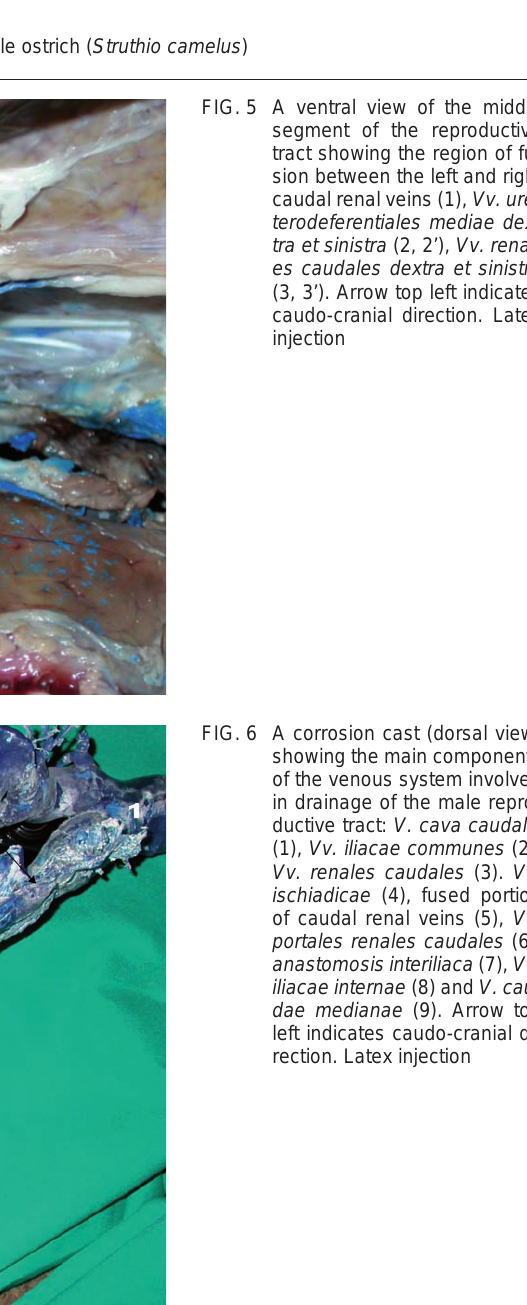
FIG. 6 A corrosion cast (dorsal view) showing the main components of the venous system involved in drainage of the male repro- ductive tract: V. cava caudalis (1), Vv. iliacae communes (2), Vv. renales caudales (3). Vv. ischiadicae (4), fused portion of caudal renal veins (5), Vv. portales renales caudales (6), anastomosis interiliaca (7), Vv. iliacae internae (8) and V. cau- dae medianae (9). Arrow top left indicates caudo-cranial